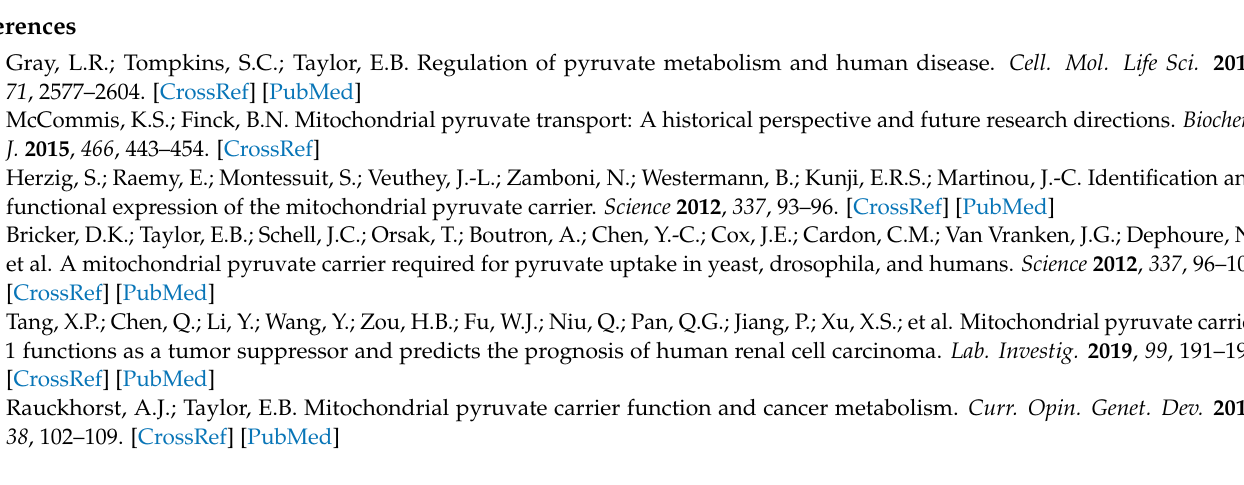
from different species; Figure S2: Protein expression and purification of yMPC1; Figure S3: Pu- rification flowchart of yMPC2 and yMPC3; Figure S4: Purification and NMR spectrum of yMPC3; Figure S5: CD spectroscopy of yMPC1 (A) and yMPC2 (B); Figure S6: Comparison of the secondary structures of yMPC1 (A) and yMPC2 (B) from NMR data and predicted by AlphaFold2; Table